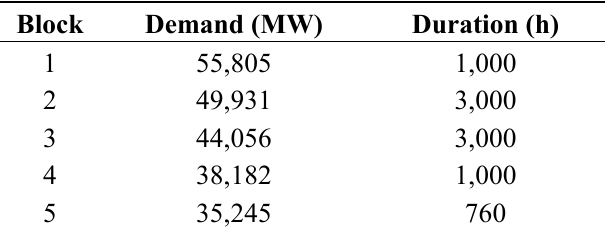
Table 7. Load blocks of the Guangdong power